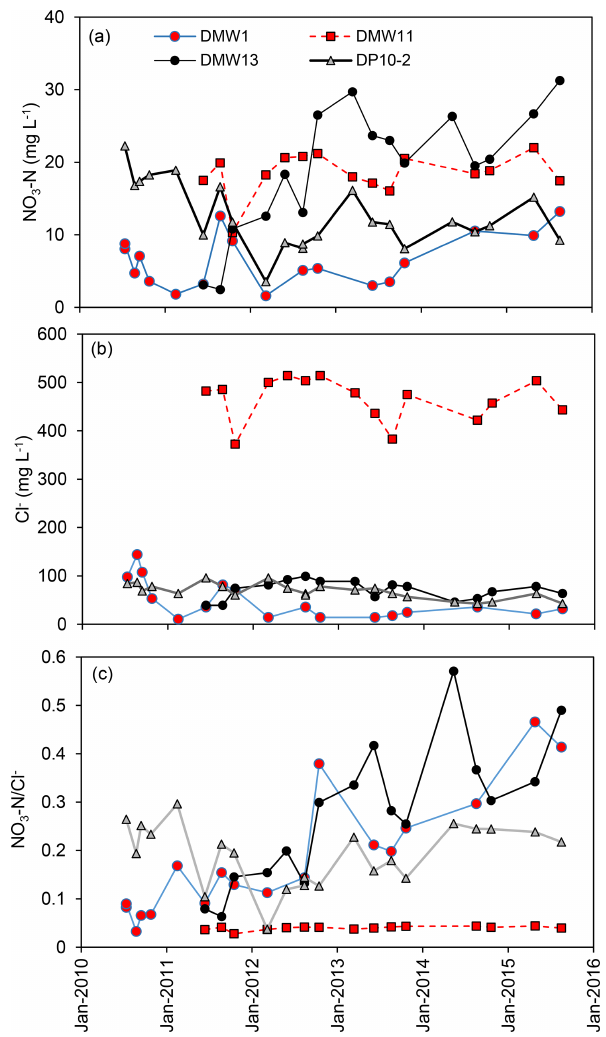
Figure 3. Temporal variations in (a) NO 3 − N, (b) Cl − , and (c) NO 3 − N / Cl − at CFO1. Only wells with NO 3 − N > 10mgL − 1 are shown.